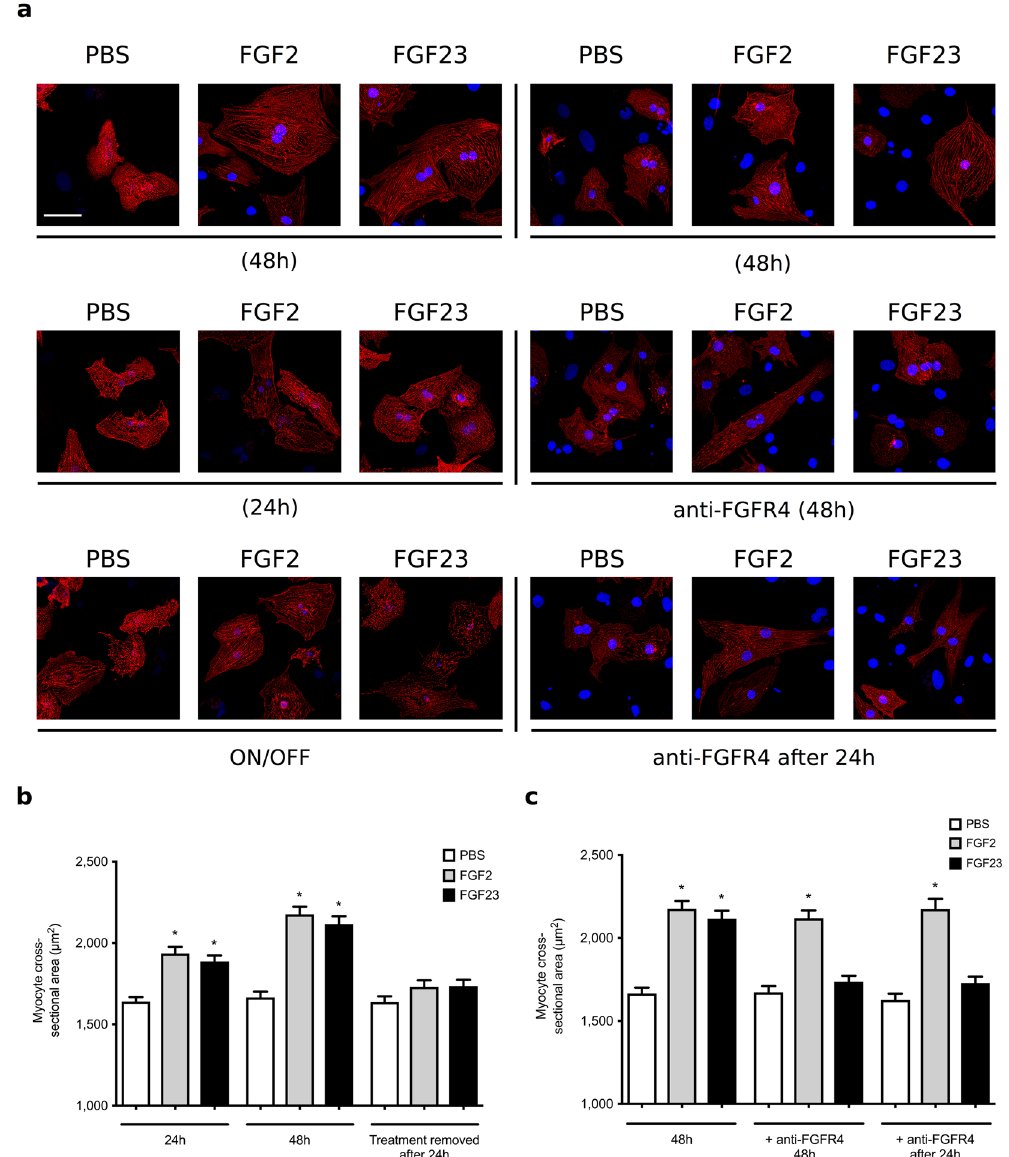
Figure 2. FGF23-induced hypertrophic growth of cultured cardiac myocytes is reversible. Analysis of hypertrophic cell growth in isolated neonatal rat ventricular myocytes (NRVM). Cells were treated with recombinant FGF23 or FGF2 at 25 ng/ml or with solvent (PBS) for various time periods. A subset of cells was co-treated with anti-FGFR4 at 10 µ g/ml. Cross-sectional cell area was determined by confocal fluorescence microscopy based on α -actinin-positive immunostaining. ( a ) Representative immunofluorescence confocal images of isolated NRVMs. Myocytes are labeled with anti- α -actinin (red), and DAPI (blue) identifies nuclei (original magnification x63, scale bar 50 µ m). ( b ) Within 24 and 48 hours of treatment, FGF23 and FGF2 significantly increase myocyte area. When NRVM are treated with FGFs for 24 hours, followed by FGF removal for 24 hours, cell area reverse back to levels of PBS-treated control cells. ( c ) When initiated at the same time, co- treatment with anti-FGFR4 blocks the development of FGF23-induced hypertrophy as analyzed after 48 hours (middle panel). When NRVM are treated with FGF23 for 24 hours and then co-treated with FGF23 and anti- FGFR4 for an additional 24 hours, myocyte area reverses back to control levels (right panel). Anti-FGFR4 co- treatment does not affect FGF2-induced hypertrophy. (150 cells per condition; n = 3 independent isolations of NRVM; * p < 0.05 compared with